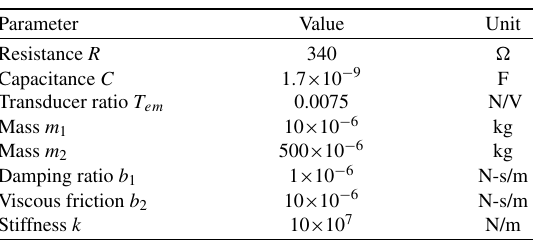
Fig. 8. The reverse piezoelectric effect and mechanical model for the taxel. Table 1 Summary of the parameters involved in the taxel’s